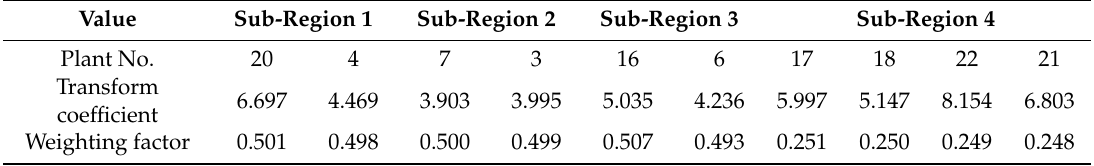
Table1. Transformcoe ffi cientandweightingfactoroftherepresentativepowerplantsineachsub-region. Value Sub-Region 1 Sub-Region 2 Sub-Region 3 Sub-Region 4 Plant No. Transform coe ffi cient Weighting